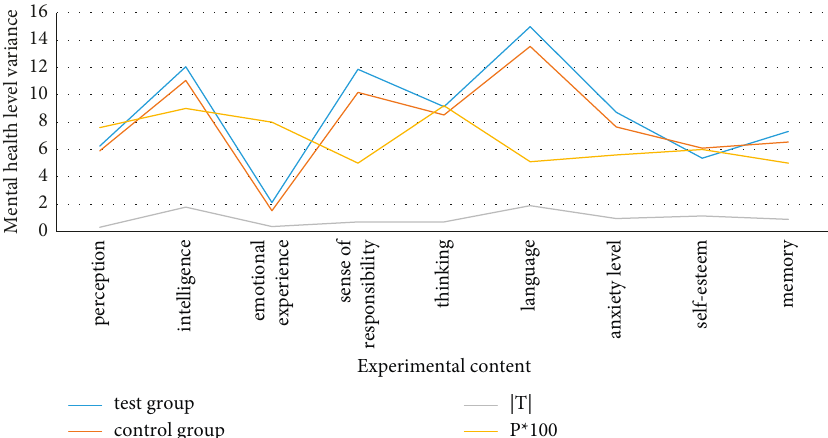
Figure 7: Comparison of mental health status between experimental group and control group before the experiment.